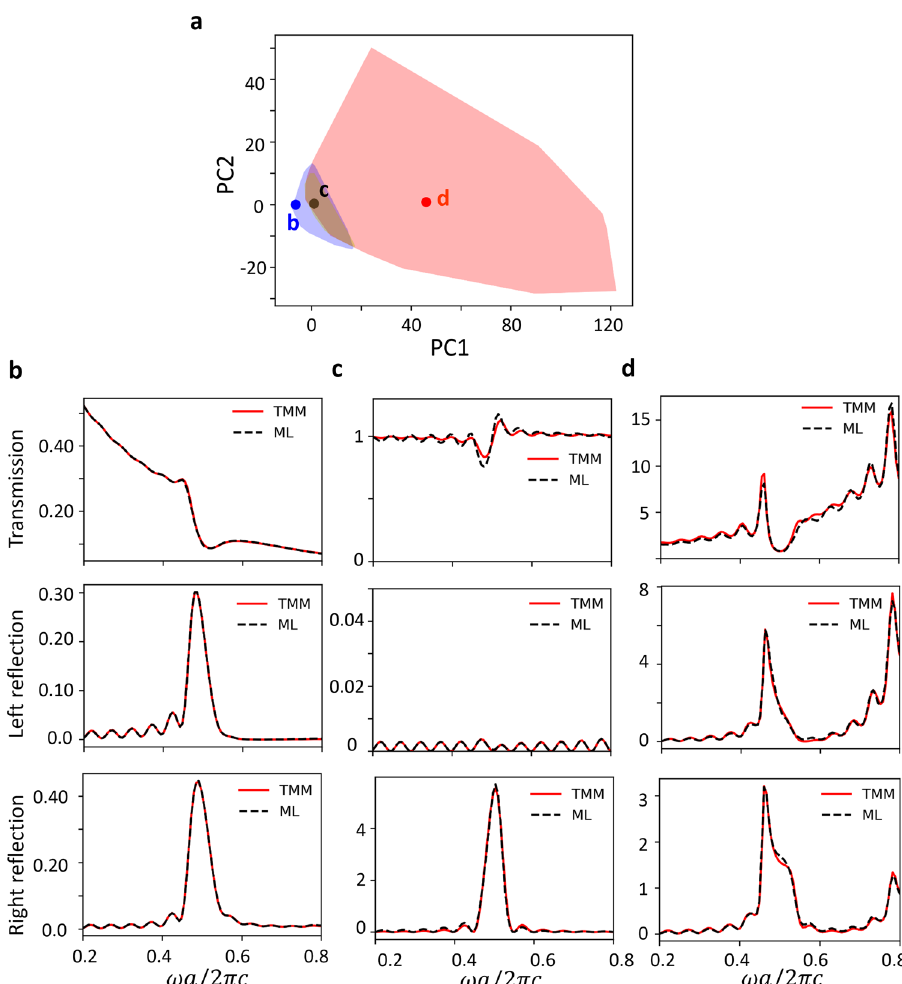
Fig. 5 Inverse design approach based on sub-manifold learning and neural adjoint method. a Convex-hulls of the feasible regions for non-Hermitian structures for the training transmission data in latent space. b – d Desired spectral responses (using Transfer Matrix Method: TMM and Machine Learning: ML) versus normalized frequency ω a /2 π c , with a the dimension of the scatterer and c the speed of light in free space, designed with adaptive gradient descent method. The initial seed is obtained within feasible sub-manifolds of lossy, gain, and balanced non-Hermitian